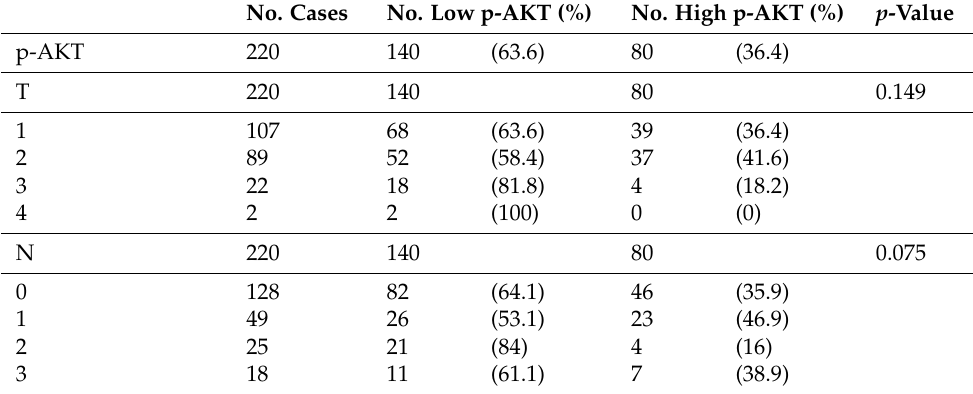
Table 1. Association between p-AKT and clinical and molecular parameters in 220 early breast cancer